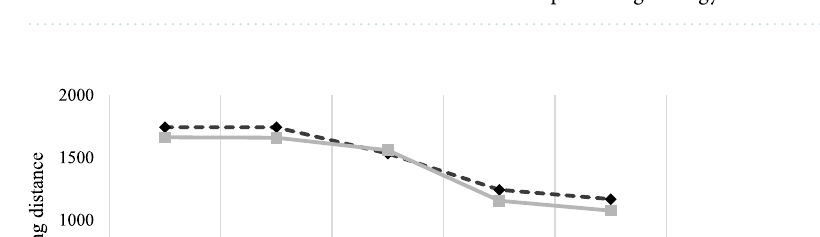
Table 6. Model results and simulation results of the S-shape routing